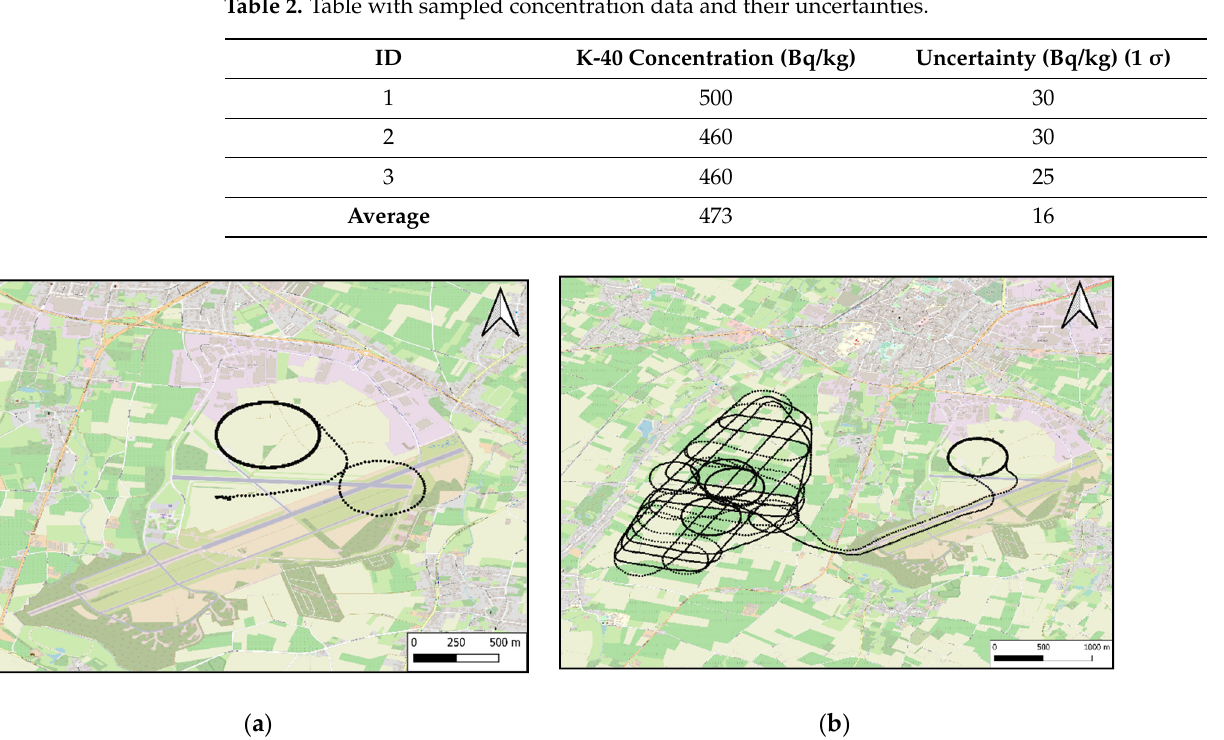
Figure 12. ( a ) Flight path of the first flight with the circular pattern. ( b ) Flight path of the second flight with the circular pattern and the grid pattern. Table 2. Table with sampled concentration data and their uncertainties.